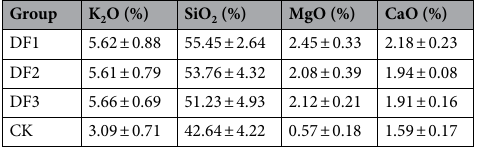
Table 4. Composition analysis of mature products. (n =